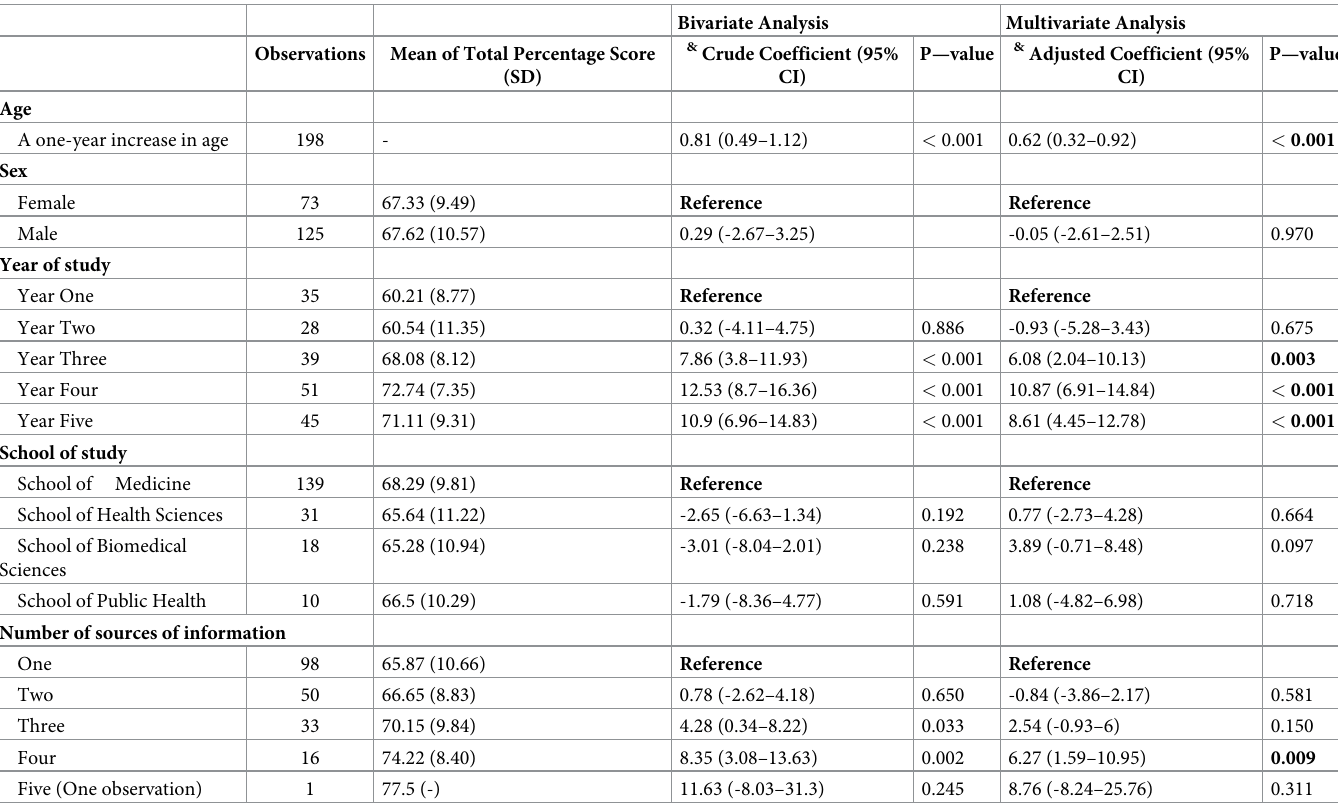
Table 3. Factors associated with the total percentage score of correct answers for all questions responded to by health professional students at Makerere University College of Health Sciences,